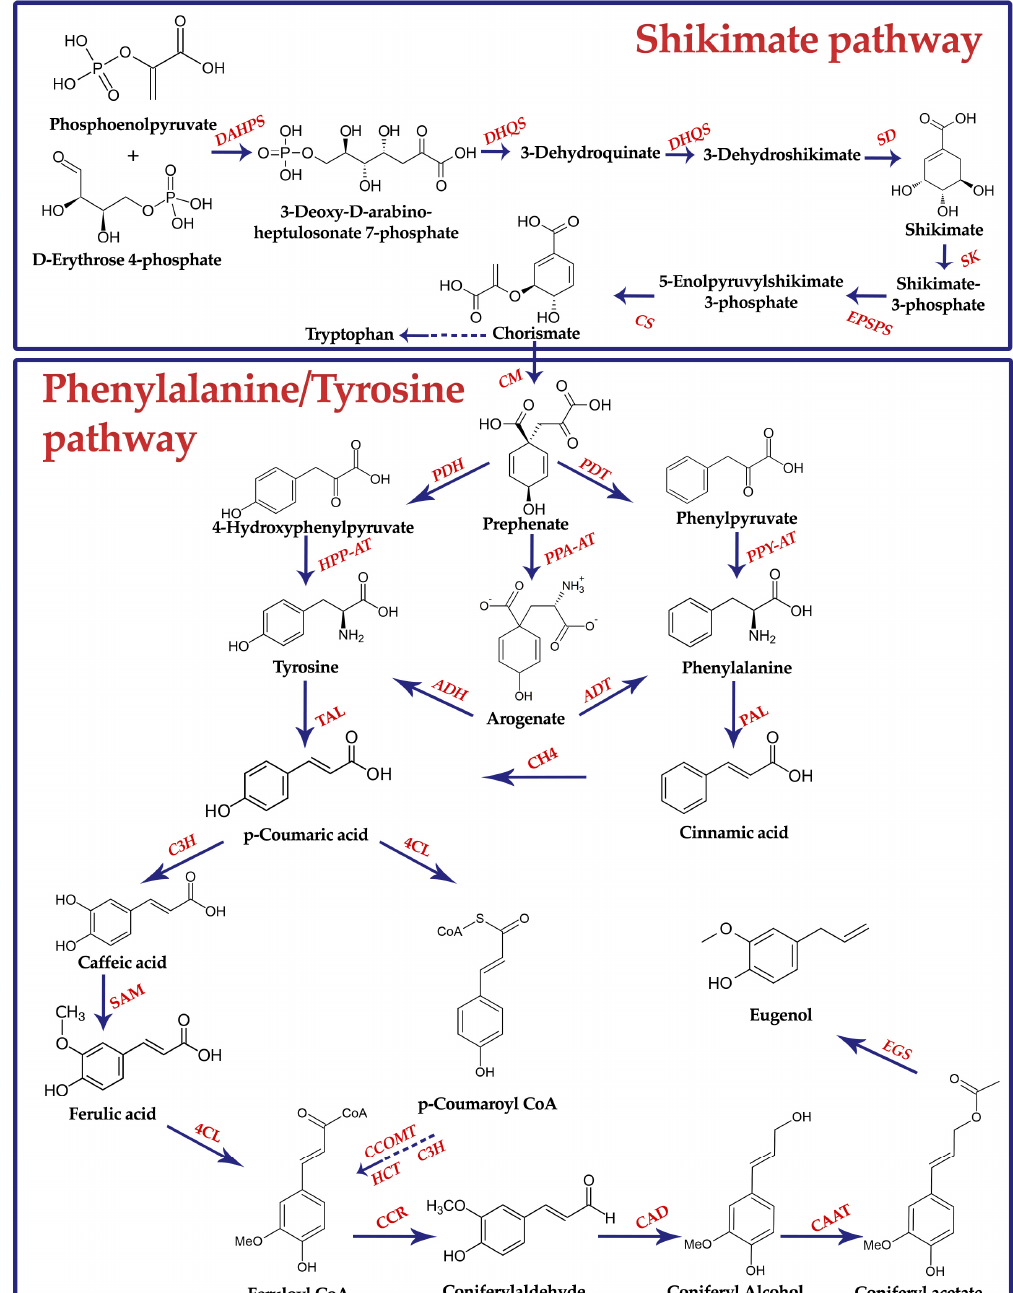
Figure 4. Aromatic amino acid biosynthesis in plants: schematic diagram of the shikimate and phenylalanine/tyrosine pathways. Dashed arrows indicate different enzymatic steps. Abbreviations: DAHPS, 3-Deoxy-d-arabino-2-heptulosonate 7-phosphate synthase; DHQS, 3-Dehydroquinate synthase; DHQD, 3-Dehydroquinate dehydratase; SD, Shikimate dehydrogenase; SK, Shikimate kinase; EPSPS, 5-Enolpyruvylshikimate 3-phosphate synthase; CS, Chorismate synthase; CM, Chorismate mutase; PDH, Prephenate dehydrogenase; PDT, Prephenate dehydratase; HPP-AT, 4-Hydroxyphenylpyruvate aminotransferase; PPY-AT, Phenylpyruvate aminotransferase; PPA-AT, Prephenate aminotransferase; ADH, Arogenate dehydrogenase; ADT, Arogenate dehydratase; TAL, Tyrosine ammonia-lyase; C4H, Cinnamate 4-hydroxylase; PAL, Phenylalanine ammonia-lyase; C3H, p-Coumarate 3-hydroxylase; 4CL, 4-Hydroxycinnamoyl CoA ligase; SAM, S-Adenosylmethionine synthetase; CCOMT, Caffeoyl-CoA O-methyltransferase; HCT, Hydroxycinnamoyl-CoA shikimate/quinate hydroxycinnamoyl transferase; CCR, Cinnamoyl reductase; CAD, Cinnamyl alcohol dehydrogenase; CAAT, Coniferyl alcohol acetyltransferase; EGS, Eugenol synthase.